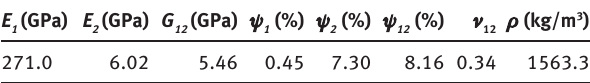
Table 2: All-zero CFRP skin elastic and damping data [5].